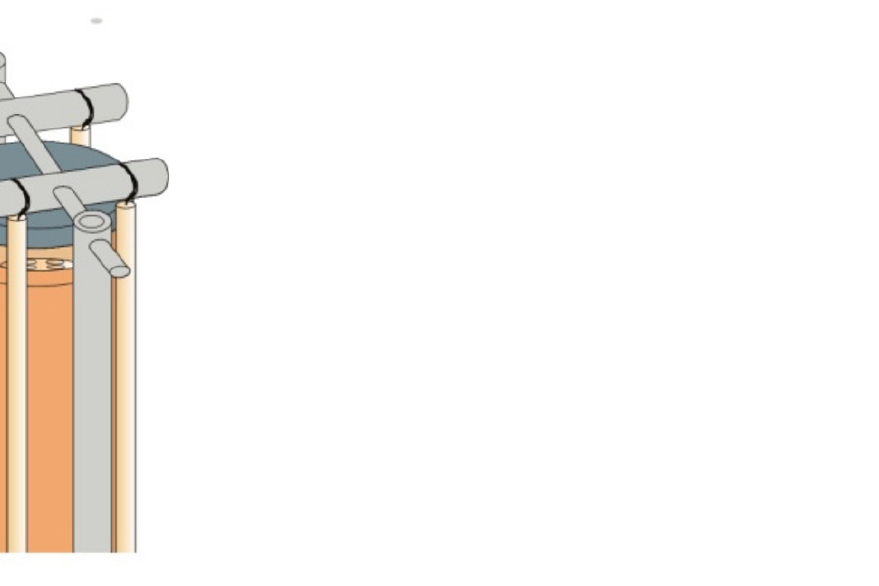
Figure 17. Probostat 4-point measurements kit for pellets, discs, or rectangular ceramic supports, from Ref. [109].